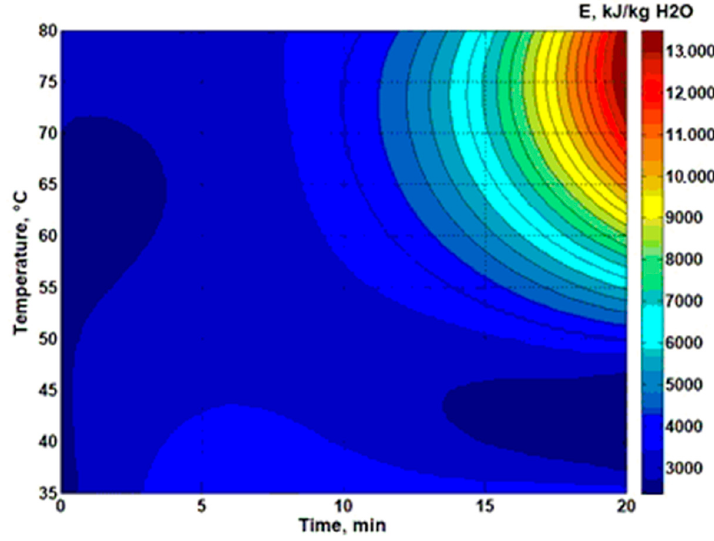
Figure 10. Total energy consumption per kg of removed water during drying of Polish lignite in the torbed installation.